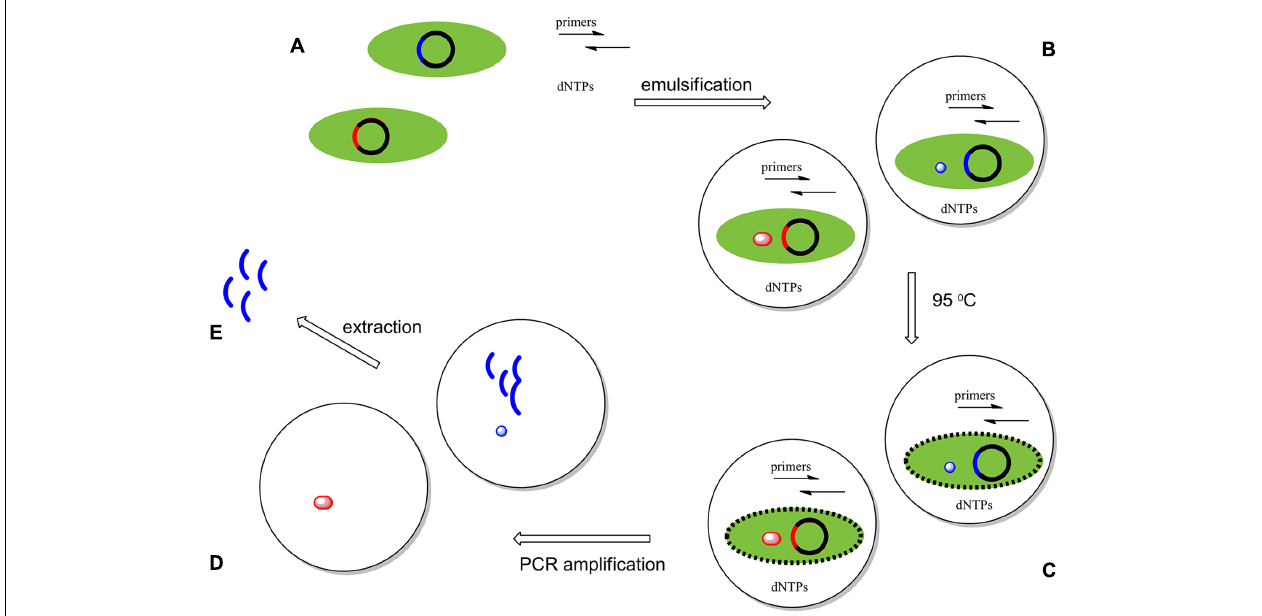
FIGURE 3 | Compartmentalized self replication (CSR) system experiments start with the creation of a library of genes encoding variants of a polymerase. Members of this library are introduced into E. coli cells by electroporation. Here, just two variant genes (red and blue) are represented.These genes drive the expression of mutant polymerases in each E. coli cell, each of which is isolated in its own water-in-oil-emulsion droplet. (B) The first cycle of PCR breaks the cell wall of the E. coli , exposing the expressed polymerase molecules and their gene to the contents of a water droplet containing all of the necessary components necessary for